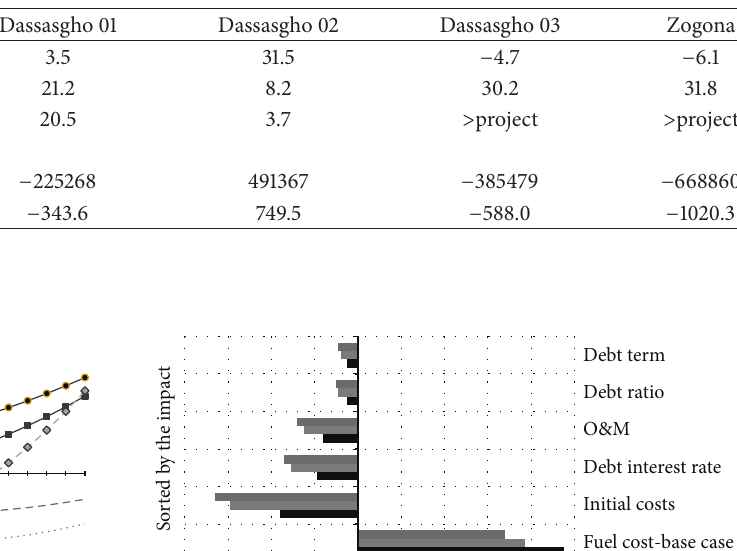
Table 4: Financial viability parameters simulated by RETScreen. Project lifetime was set at 25 years.